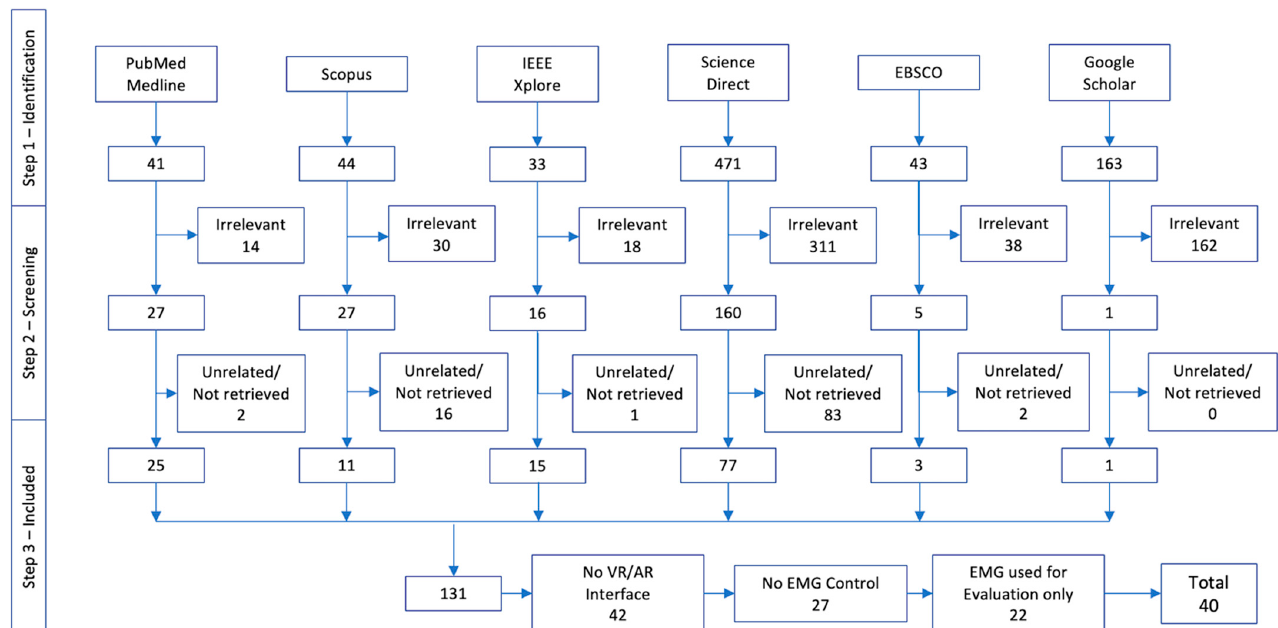
Figure 3. Number of records identified from each database for the systematic literature review.